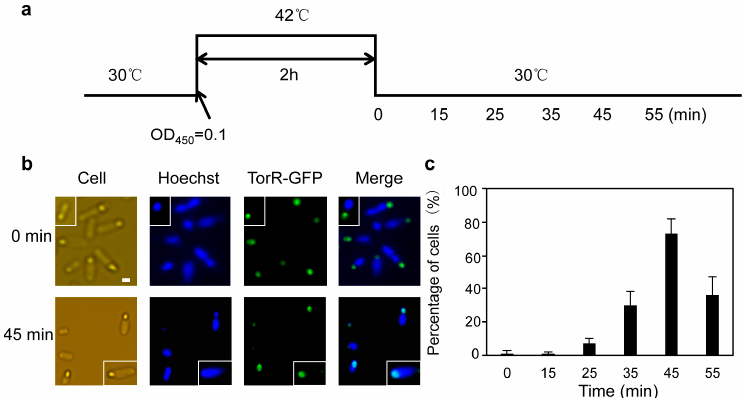
Figure 2. The TorR ‐ GFP focus co ‐ localizes with the nucleoid in a cell ‐ cycle ‐ dependent fashion. ( a ) Exponentially growing W3110 Δ torRdnaC2 cells carrying pTorR ‐ GFP in ABTGcasa medium with IPTG for expression of TorR ‐ GFP were shifted from the permissive temperature (30 °C) up to the non ‐ permissive temperature (42 °C). After 2 h incubation at 42 °C, the synchronized cells were shifted down to 30 °C, and sampled at the time points indicated and fixed in 70% ethanol; ( b ) Subcellular localizations of TorR ‐ GFP and the nucleoid were visualized by Axio Imager A2 fluorescence microscope (Carl Zeiss) and AxioCam MRC5 camera after 30 min staining in Hoechst33258 which dyes DNA specifically. The TorR ‐ GFP focus is in green, the nucleoid is in blue, the merged image of TorR ‐ GFP focus with the nucleoid is in cyan. The time points at which cells were collected are as indicated on the left; ( c ) The percentage (%) of cells with co ‐ localized TorR ‐ GFP focus with the nucleoid was counted and shown as a function of time (min) at 30 °C. More than 100 cells were included for each calculation at each time point. The values are the average of three individual experiments and the standard errors are given as the error bars.